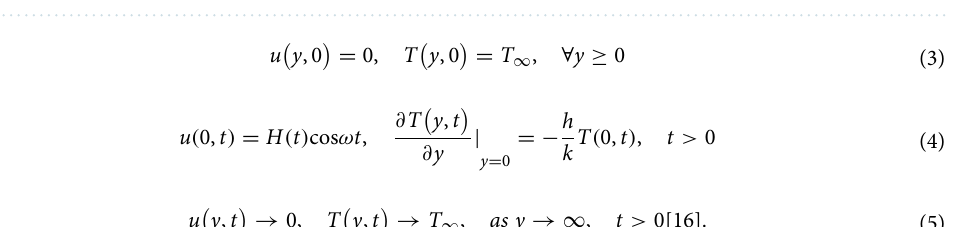
Figure 1. Geometry of the